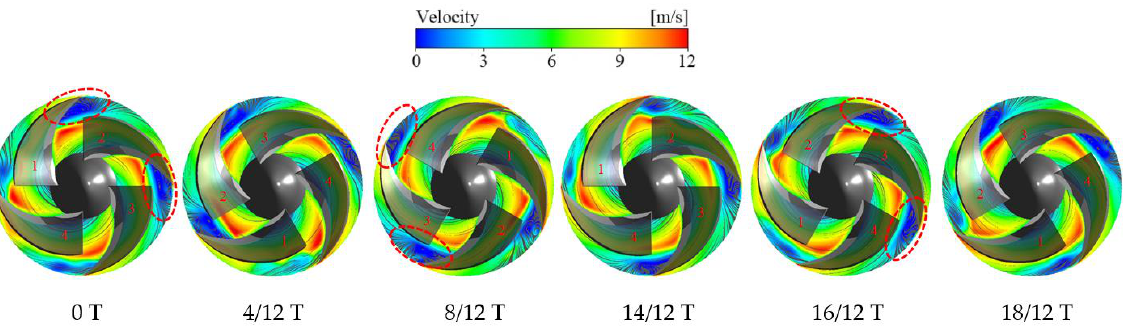
Figure 15. Velocity streamline diagram of impeller outlet section at different time ( δ = 0.8 mm).